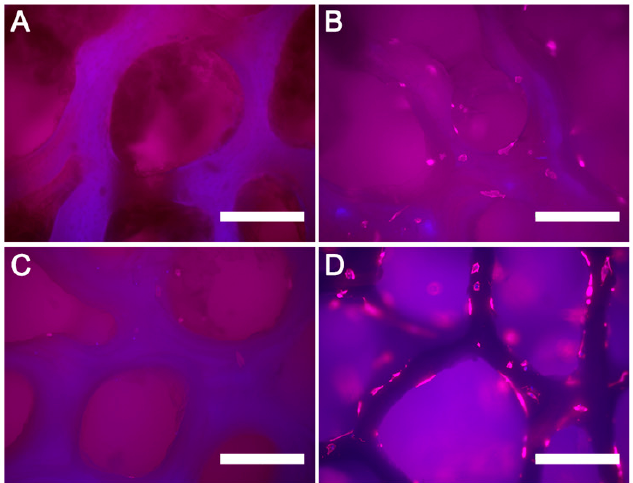
Figure 7. Cells attached on different treated bovine bone blocks assessed through phalloidin stain- ing. ( A ) Raw bone, ( B ) boil (6 h), ( C ) initial boiling (6 h) followed by 550 °C sintering (6 h), ( D ) initial ( A ) Raw bone, ( B ) boil (6 h), ( C ) initial boiling (6 h) followed by 550 ◦ C sintering (6 h), ( D ) initial boiling (6 h) followed by 1100 °C sintering (6 h). Scale bar = 1050 µm (representative images of n = boiling (6 h) followed by 1100 ◦ C sintering (6 h). Scale bar = 1050 µ m (representative images of n = 3) 3) (Phalloidin = red, DAPI = blue). (Phalloidin = red, DAPI =